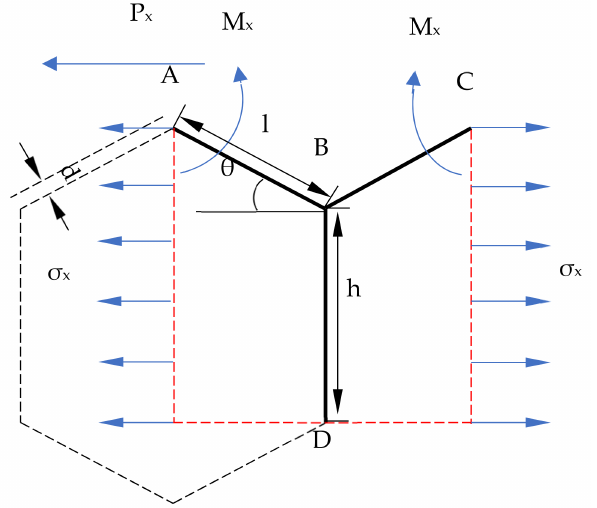
Figure 4. The model for the force in the x direction in the unit structure of FBLPG. D—bore wall depth; l—the length of the bevel edge of the unit cell; h—the height of the vertical side of the unit cell; Mx—matrix in the x direction; σ x—stress in the x direction; Px—horizontal